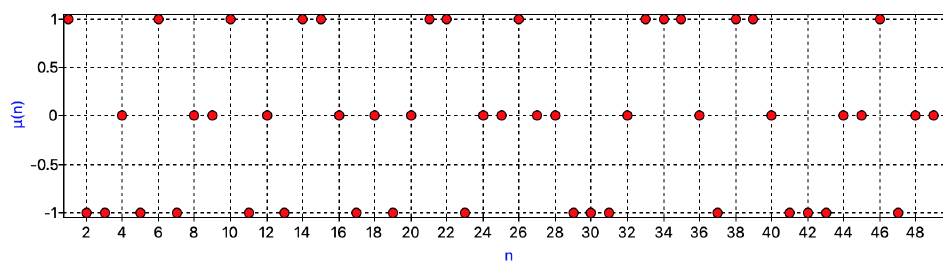
Figure 5. The simulation for µ ( n ) with 1 ≤ n ≤ 50.